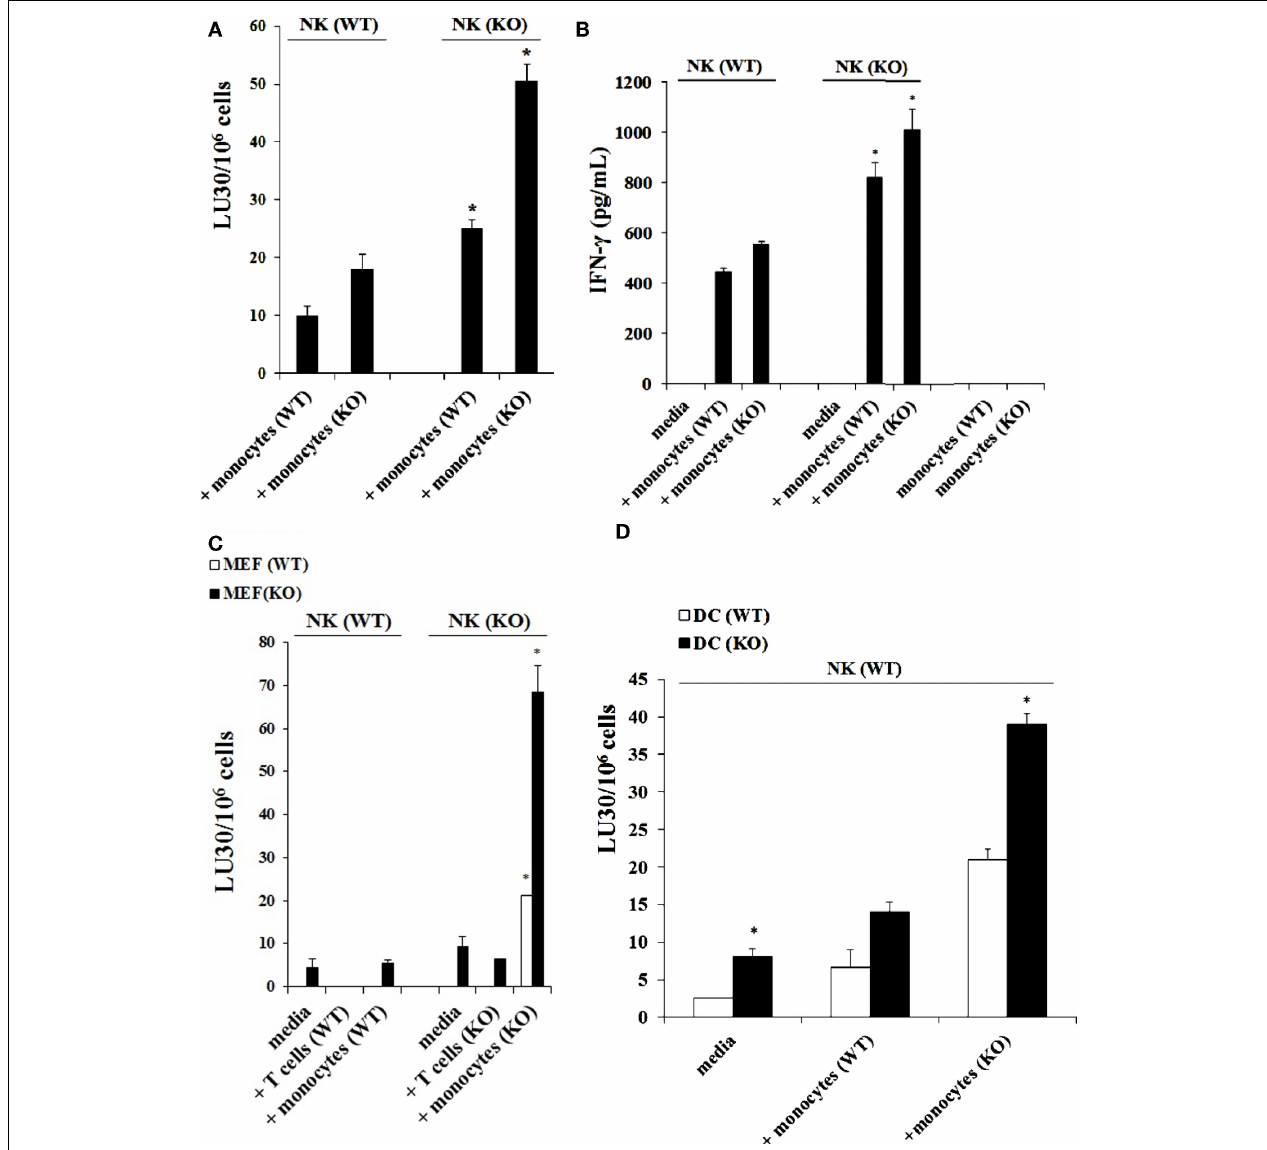
knockout mice or monocytes from wild type or Cox-2 flox/flox ;LysM Cre/ + mice for 7days. Afterward, NK cells were used as effectors against wild type MEFs or MEFs with specific COX-2 deletion. The cytotoxic function of NK cells against MEFs was determined using a standard 4h 51 Cr release assay. The lytic units 30/10 6 cells were determined using inverse number of NK cells required to lyse 30% of the target cells (cid:2) 100. * P < 0.05 is for the difference in cytotoxicity between IL-2-treated NK cells from control and Cox-2 flox/flox ;LysM Cre/ + mice cultured with monocytes or T cells (C) . IL-2-treated (1 (cid:2) 10 4 U/million) NK cells obtained from wild type mice were cultured with monocytes from wild type mice or Cox-2 flox/flox ;LysM Cre/ + mice for 7days before the cells were used as effector cells in a standard 4h 51 Chromium release assay. Monocyte-derived DCs from wild type or Cox-2 flox/flox ;LysM Cre/ + mice were prepared as described in Section “Materials and Methods” and used as target cells. The lytic units 30/10 6 cells were determined using inverse number of NK cells required to lyse 30% of the target cells (cid:2) 100. * P < 0.05 was obtained for the difference in IL-2-treated NK cell-mediated lysis between DCs from control mice and from those of Cox-2 flox/flox ;LysM Cre/ + mice (D) . One of several representative experiments is shown in this